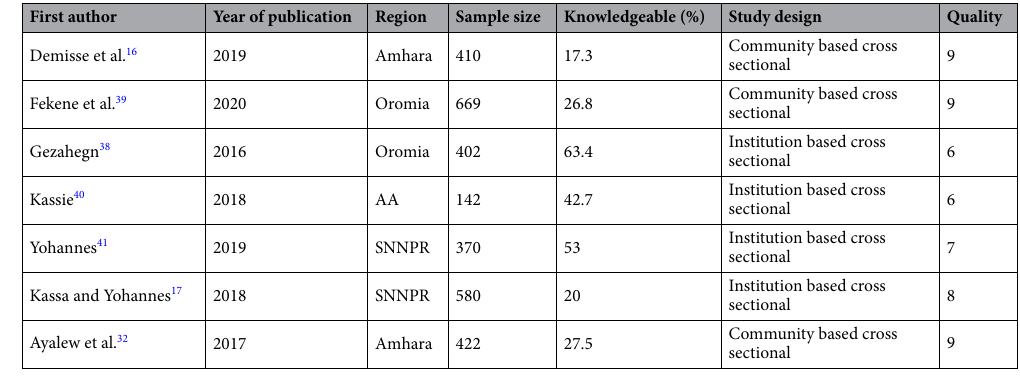
Table 1. Characteristics of studies included in the final